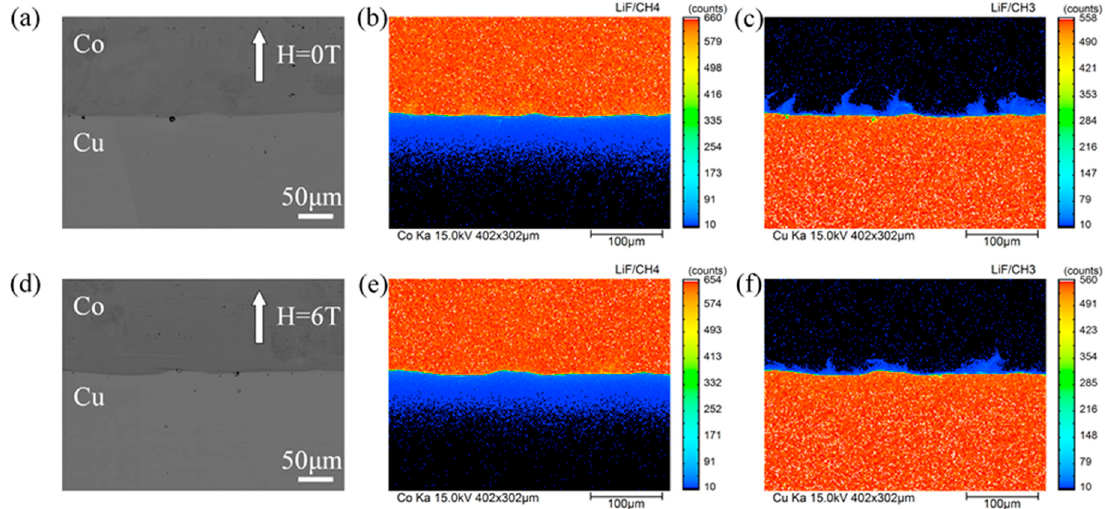
Figure 2. EPMA mapping analysis of the diffusion couple annealed at 1214 K for 9 h with and without the high magnetic field. The angle between the magnetic field direction and the cobalt diffusion direction is 180°. ( a , d ) back scattered electron (BSE) images for 0 T and 6 T, ( b , c ) corresponding cobalt distribution and copper distribution of ( a ), respectively, ( e , f ) corresponding cobalt distribution and copper distribution of ( d ), respectively.